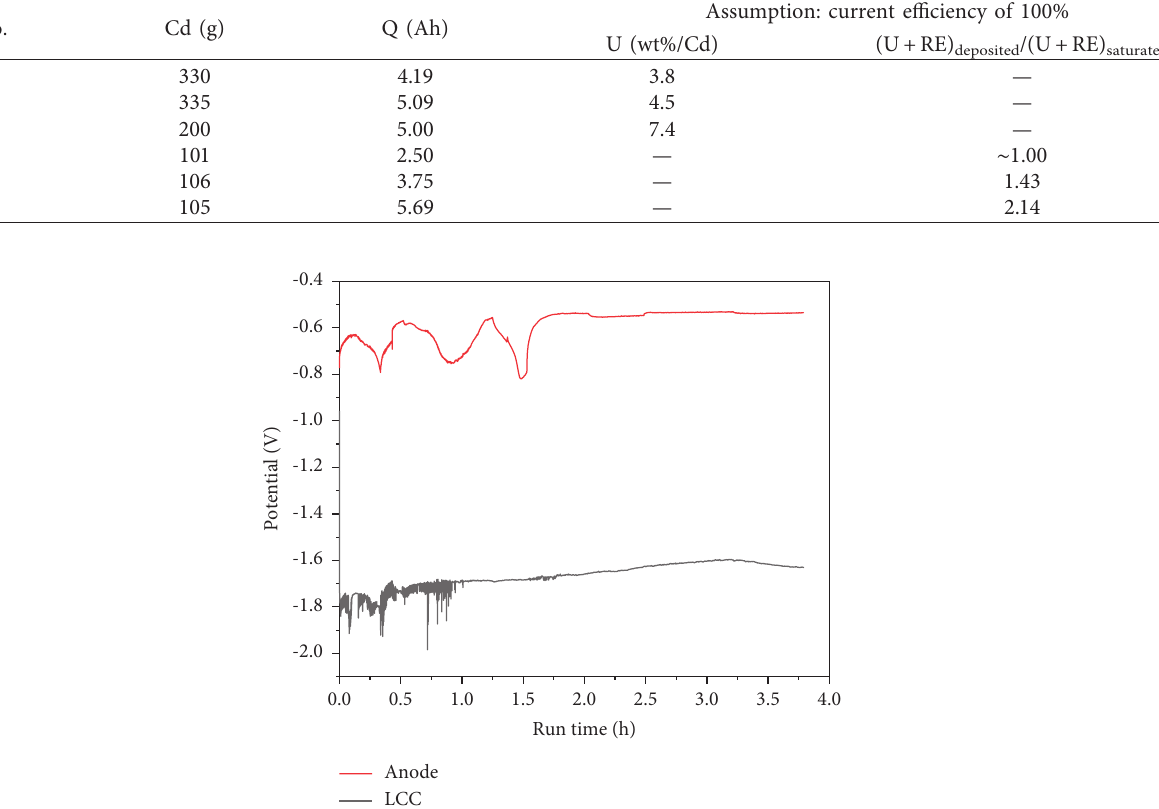
° C. 3 -NdCl 3 -CeCl 3 -LaCl 3 at 500